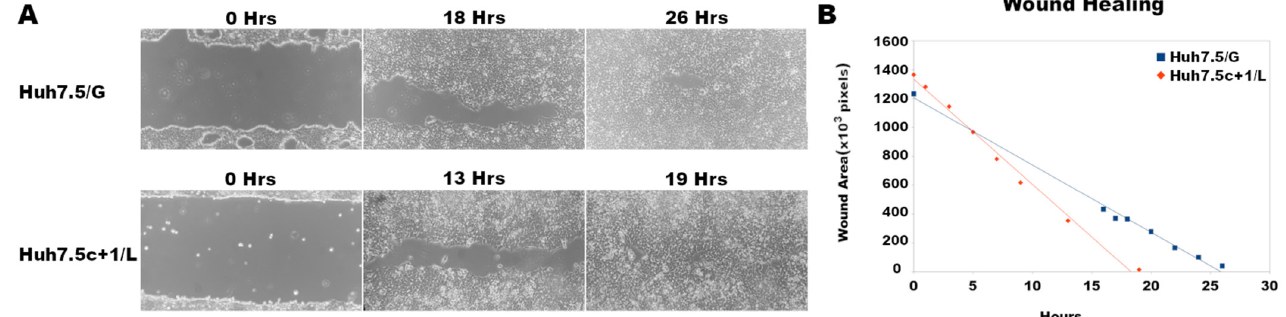
Figure 5 . The expression of Core+1/Long increases the migration of Huh7.5c+1/L cells. ( A ) Representative images of a wound-healing assay in Huh7.5/G (control) and Huh7.5c+1/L cell monolayers. ( B ) Quantitation of the wound closure over 30 hrs of cell migration .